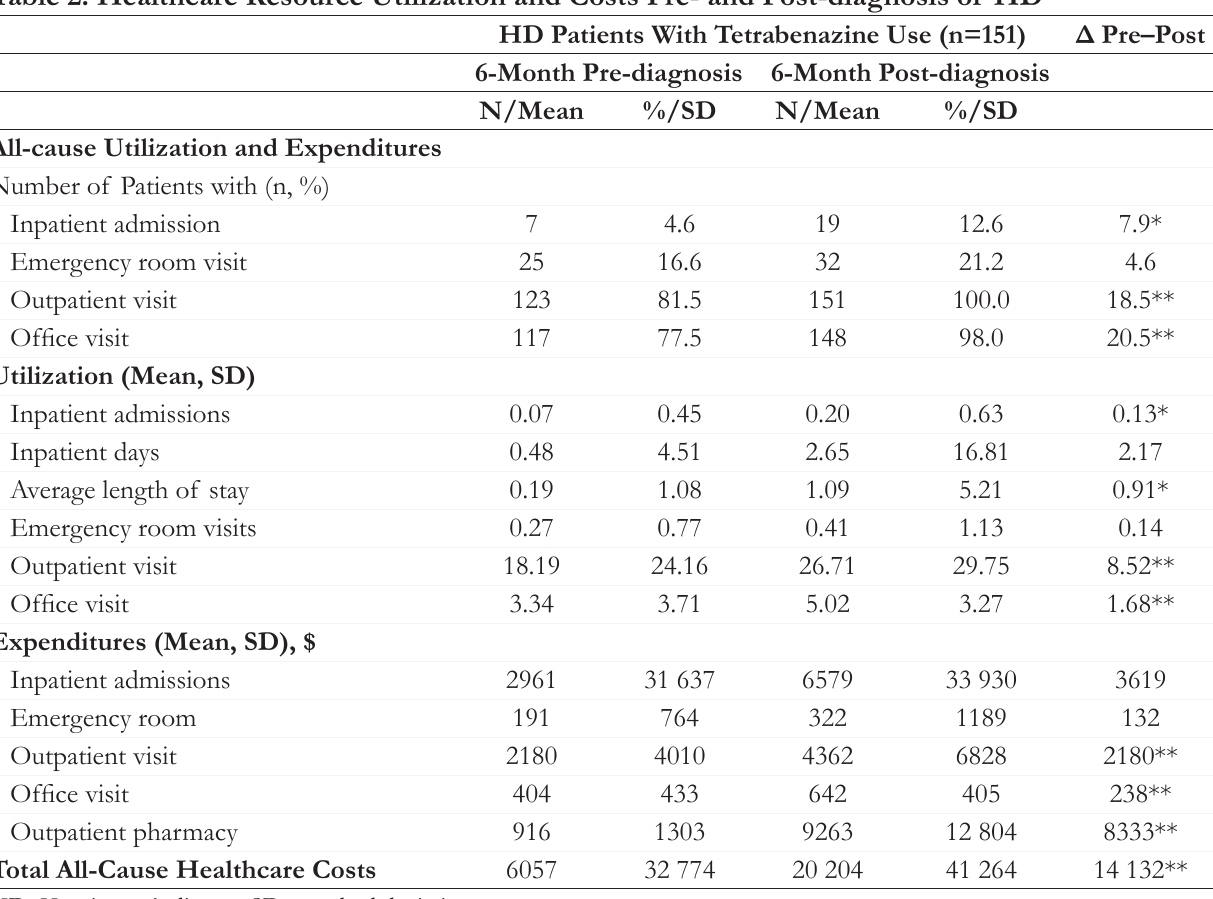
Table 2. Healthcare Resource Utilization and Costs Pre- and Post-diagnosis of HD HD Patients With Tetrabenazine Use (n=151) Δ Pre–Post